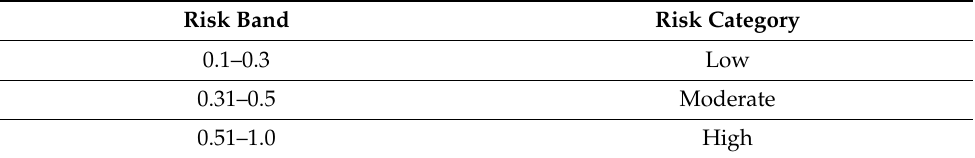
Table 9. Proposed output risk bands for the scenarios.